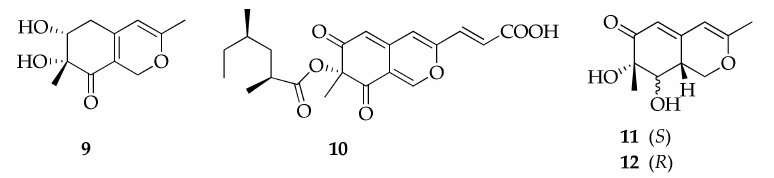
Figure 3. Structures of azaphilones.